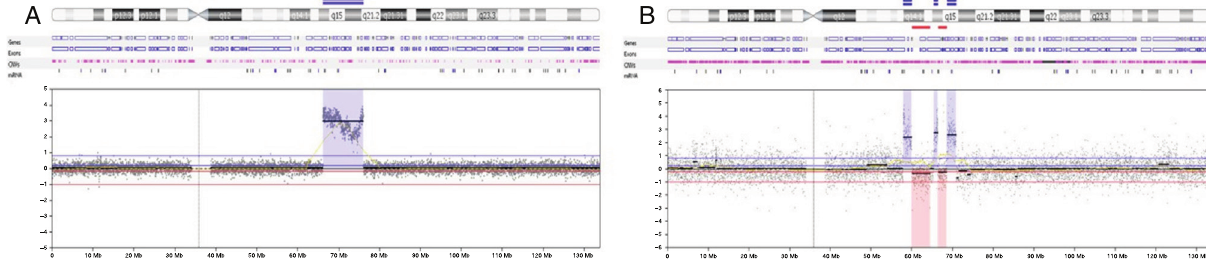
(A) Array-CGH profile of chromosome 12 showing the high copy number gain (amplification) of 1Mb at 12q14.3q21.2 in case 1. (B) Array-CGH profile of chromosome 12 showing a complex pattern consisting of three genomic regions exhibiting high copy number (amplifications) at 12q13.3q14.1 (0.2 Mb), 12q14.3 (0.1 Mb) and 12q15 (0.2 Mb), interpolated with copy number losses of low